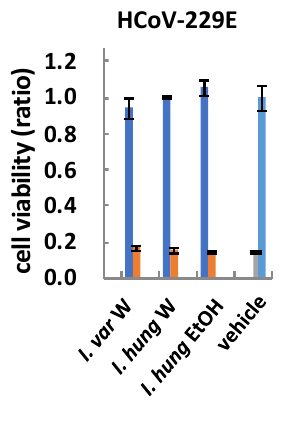
Figure 6. Human coronavirus 229E (HCoV-229E) protective activity of Iris rhizomes extracts. The cells infected by HCoV-229E were treated with the samples (orange) or vehicle (grey), any difference between them would indicate protective effects against HCoV-229E infection. The uninfected cells were also treated with the samples (dark blue) or vehicle only (light blue), serving as a control for cell viability after the treatment with the samples or vehicle. I. var W, I. variegata rhizomes (water extract); I. hung W, I. hungarica rhizomes (water extract); I. hung EtOH, I. hungarica rhizomes (ethanolic extract).